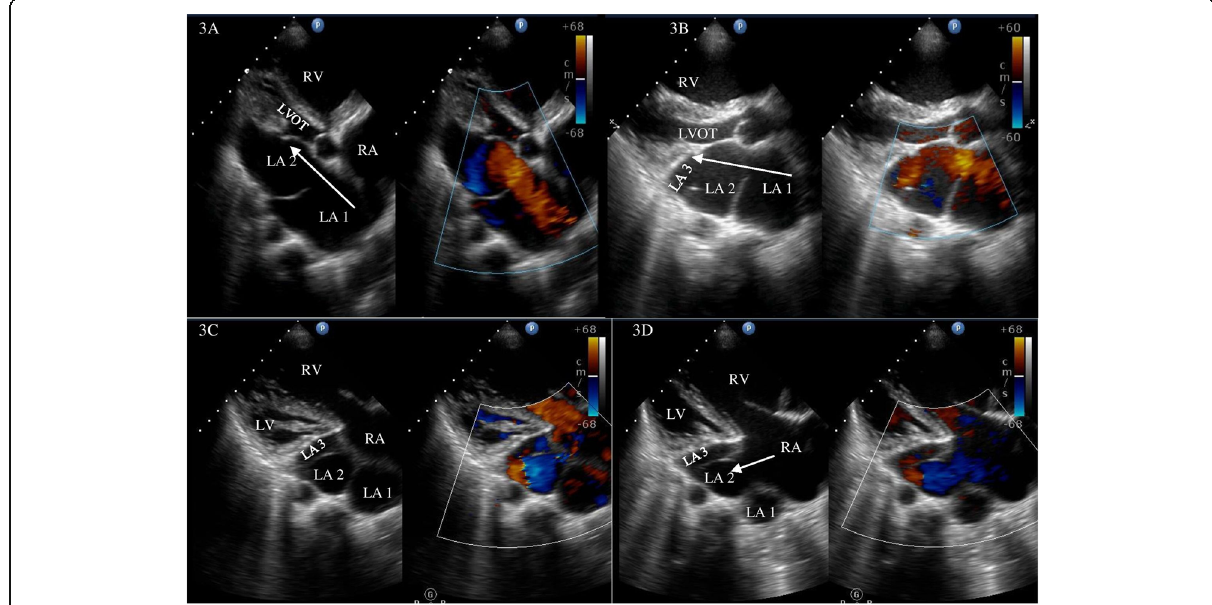
Fig. 3 Transthoracic echocardiography in parasternal long axis (PLAX) view showing left atrium (LA) divided into 2 chambers by a non-obstructive membrane with color Doppler showing uninterrupted blood flow from LA1 to LA2 ( A ). Modified PLAX view showing 2 membranes in the LA diving it into 3 chambers with uninterrupted blood flow from LA1 to LA3 ( B ). Arrow in A and B showing the direction of flow of blood. Modified PLAX view showing all 3 chambers in LA with presence of ASD between LA2 and right atrium with predominant right to left shunt ( C , D ). Arrow in D shows the right to left shunt. RA, right atrium; LA, left atrium; RV, right ventricle; LV, left ventricle; LVOT, left ventricular outflow